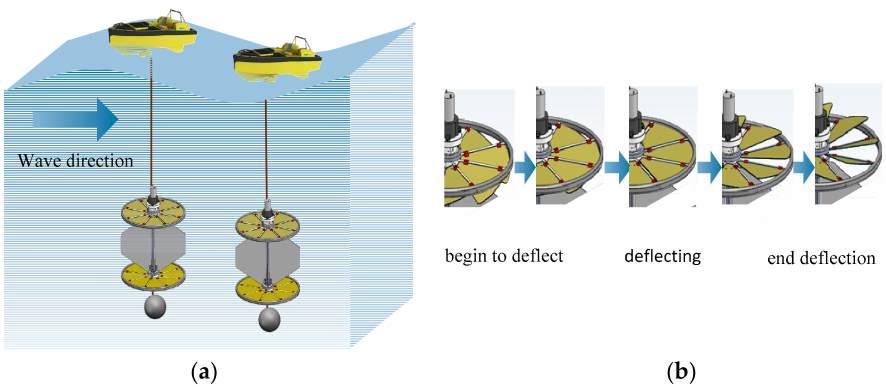
Figure 5. Blade commutation process of rigid blade WEC: ( a ) Crest and trough position; ( b ) Blade